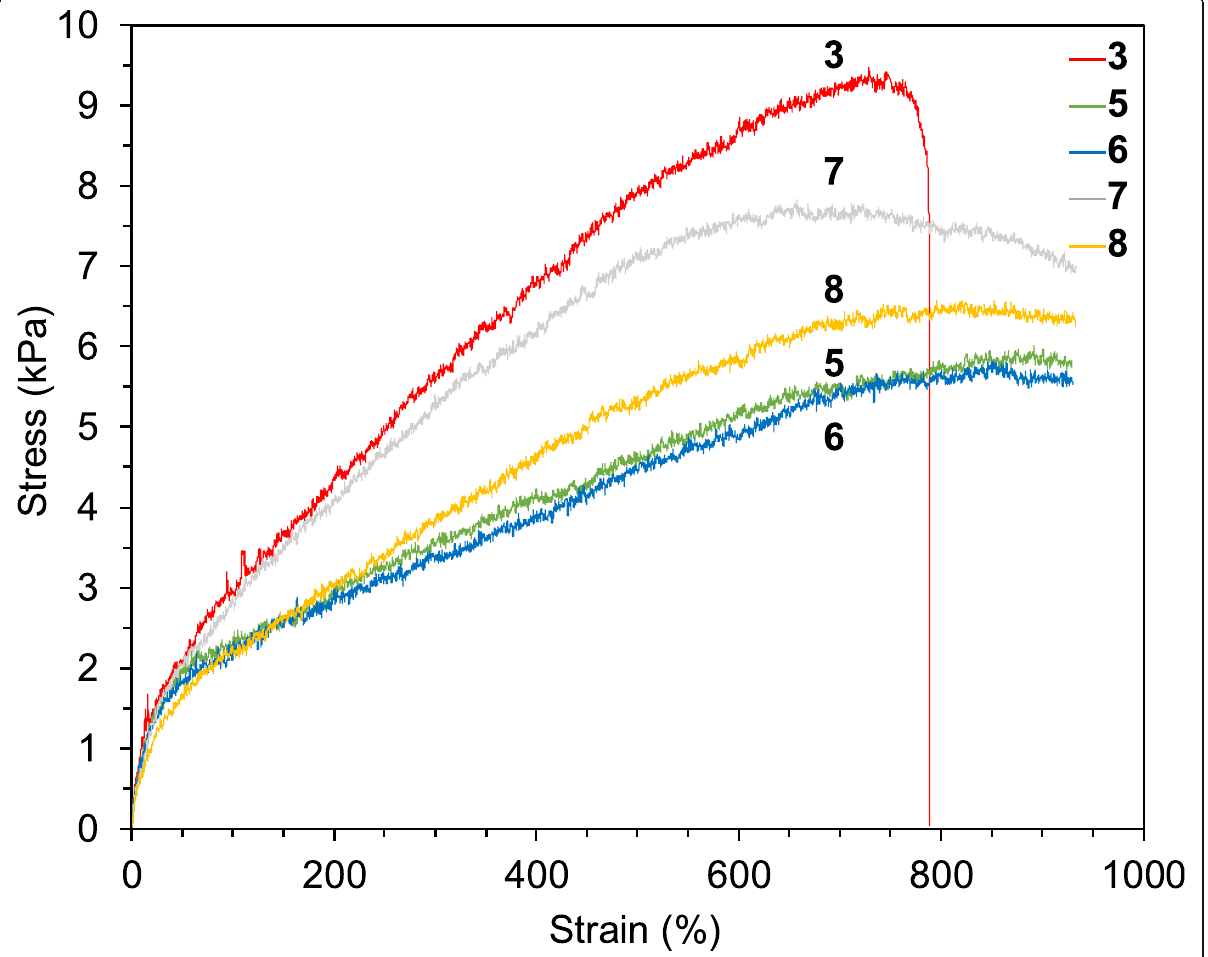
Fig. 6 Tensile stress – strain curves for 30 wt% PNIPAM hydrogel composites with 0.02 wt% nano-concave-convex surface ZrO 2 MARIMO (3), with 0.02 wt% HEMA-impregnated ZrO 2 MARIMO (5), with 0.02 wt% NIPAM-impregnated ZrO 2 MARIMO (6), with 0.02 wt% BMA-impregnated ZrO 2 MARIMO (7), and with 0.02 wt% CHMA-impregnated ZrO 2 MARIMO